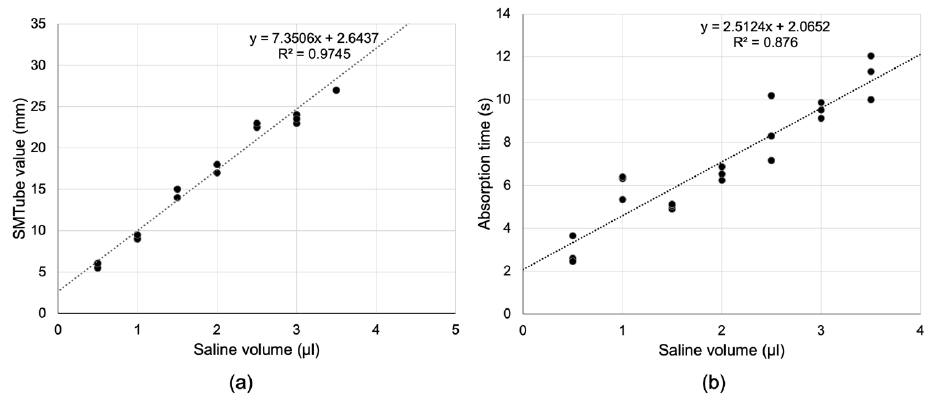
Figure 1. Results of in vitro experiments. ( a ) The strip meniscometry tube (SMTube) value correlated significantly with the saline volume. ( b ) Similarly, the absorption time correlated significantly with the saline volume.